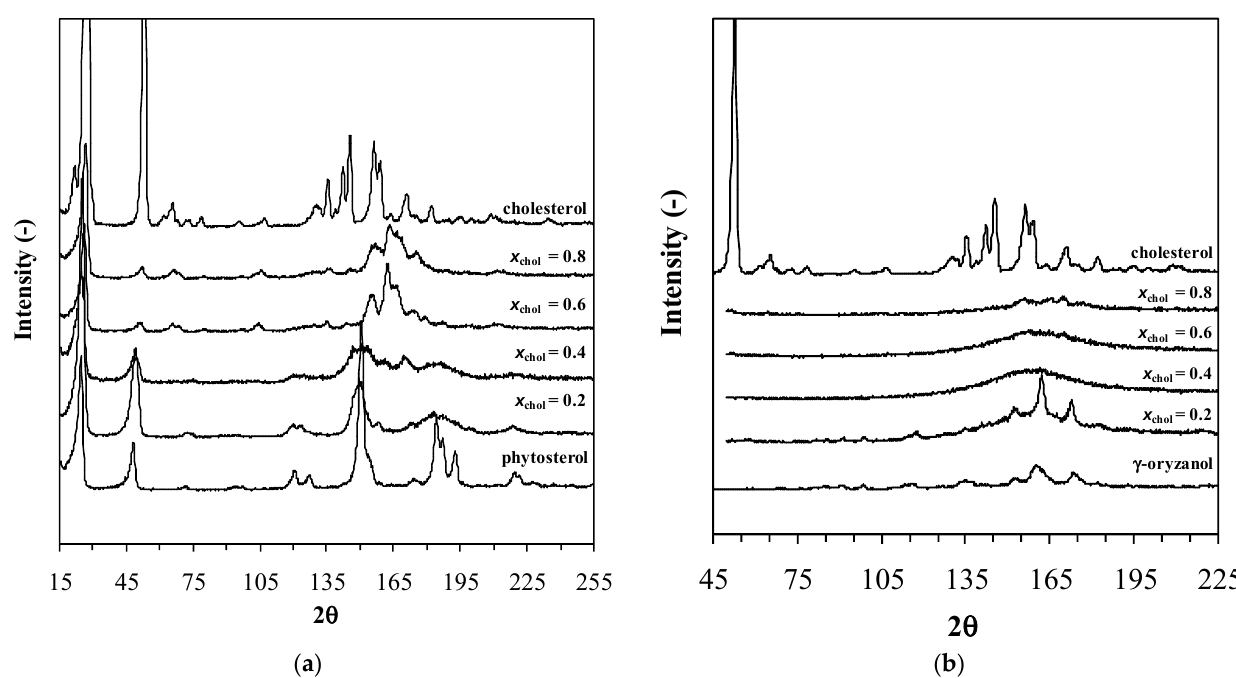
Figure 5. Powder X-ray difractograms for ( a ) cholesterol + phytosterol and ( b ) cholesterol + γ -oryzanol mixtures.